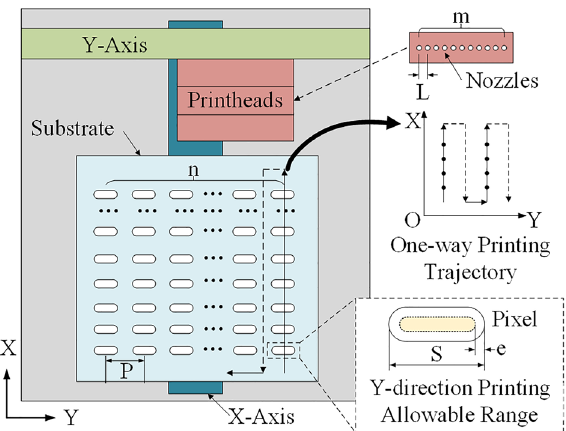
Figure 6. The layout of the display pixel printing